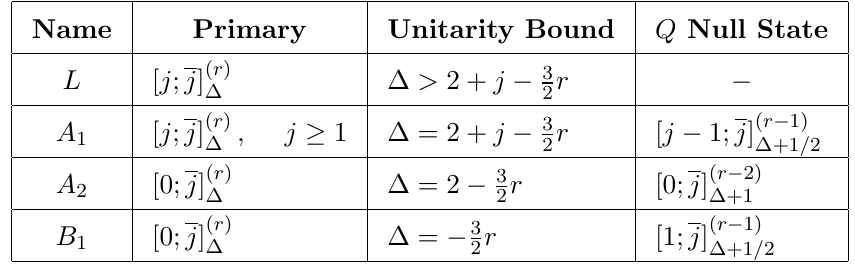
Table 10 . Q shortening conditions in four-dimensional N = 1 SCFTs.